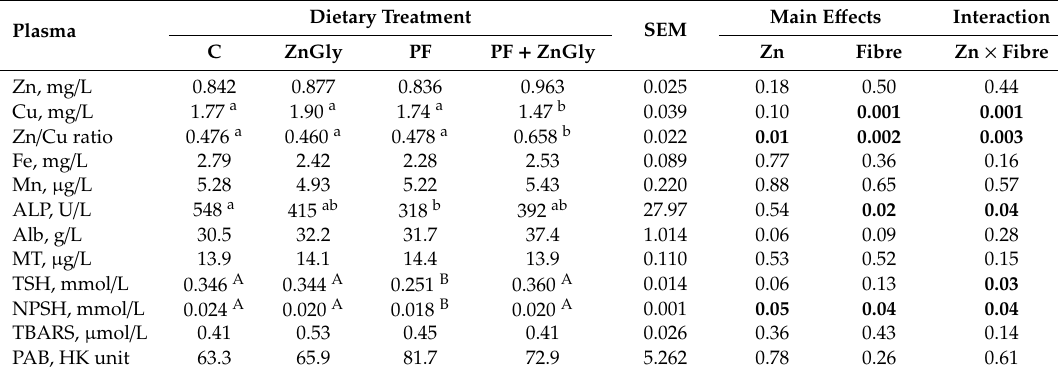
Table 4. Plasma concentration of Zn, Cu, Fe and Mn; total- and non-protein-bound thiols (TSH and NPSH, respectively); albumin (Alb); metalothionein 1 (MT); thiobarbituric acid reactive substances (TBARS); prooxidat-antioxidant balance (PAB); and plasma activity of alkaline phosphatase (ALP) in piglets fed diets di ff ering in zinc and fibre source. Plasma